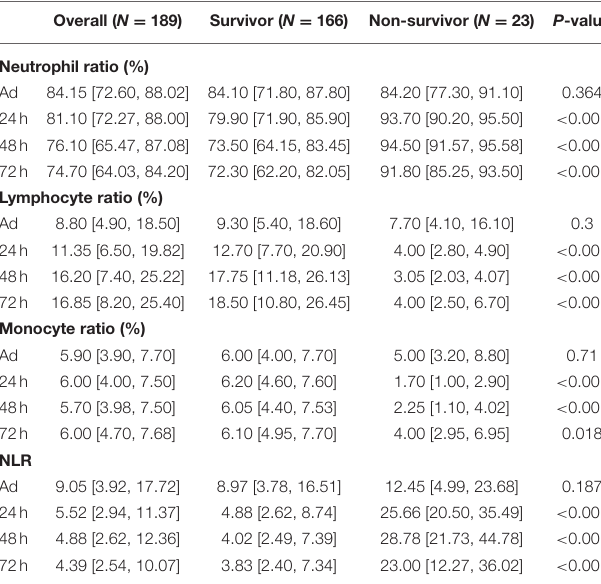
TABLE 2 | The dynamic changes of immune cell ratios and neutrophil to lymphocyte ratios (NLR) in patients with EHS.